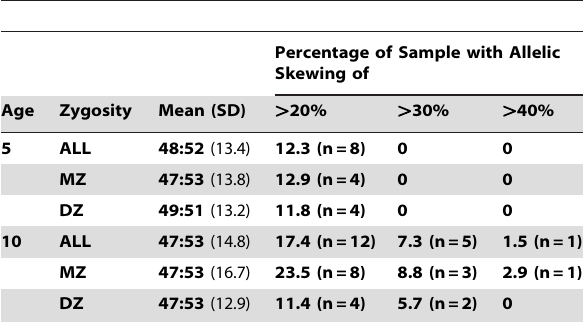
Table 1. Skewed X-inactivation ratios (deviation from 50:50) in females at ages 5 and 10 years (The percentage reported is cumulative for each group).